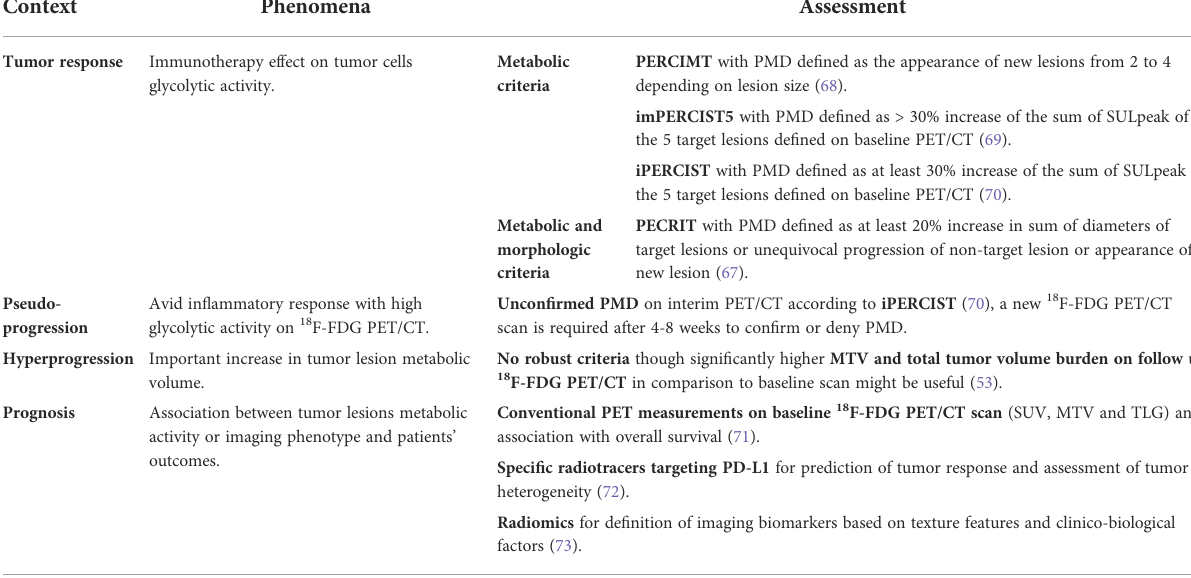
TABLE 3 Summary of metabolic fi ndings in association with the metabolic criteria for the assessment of response to immunotherapy. Context